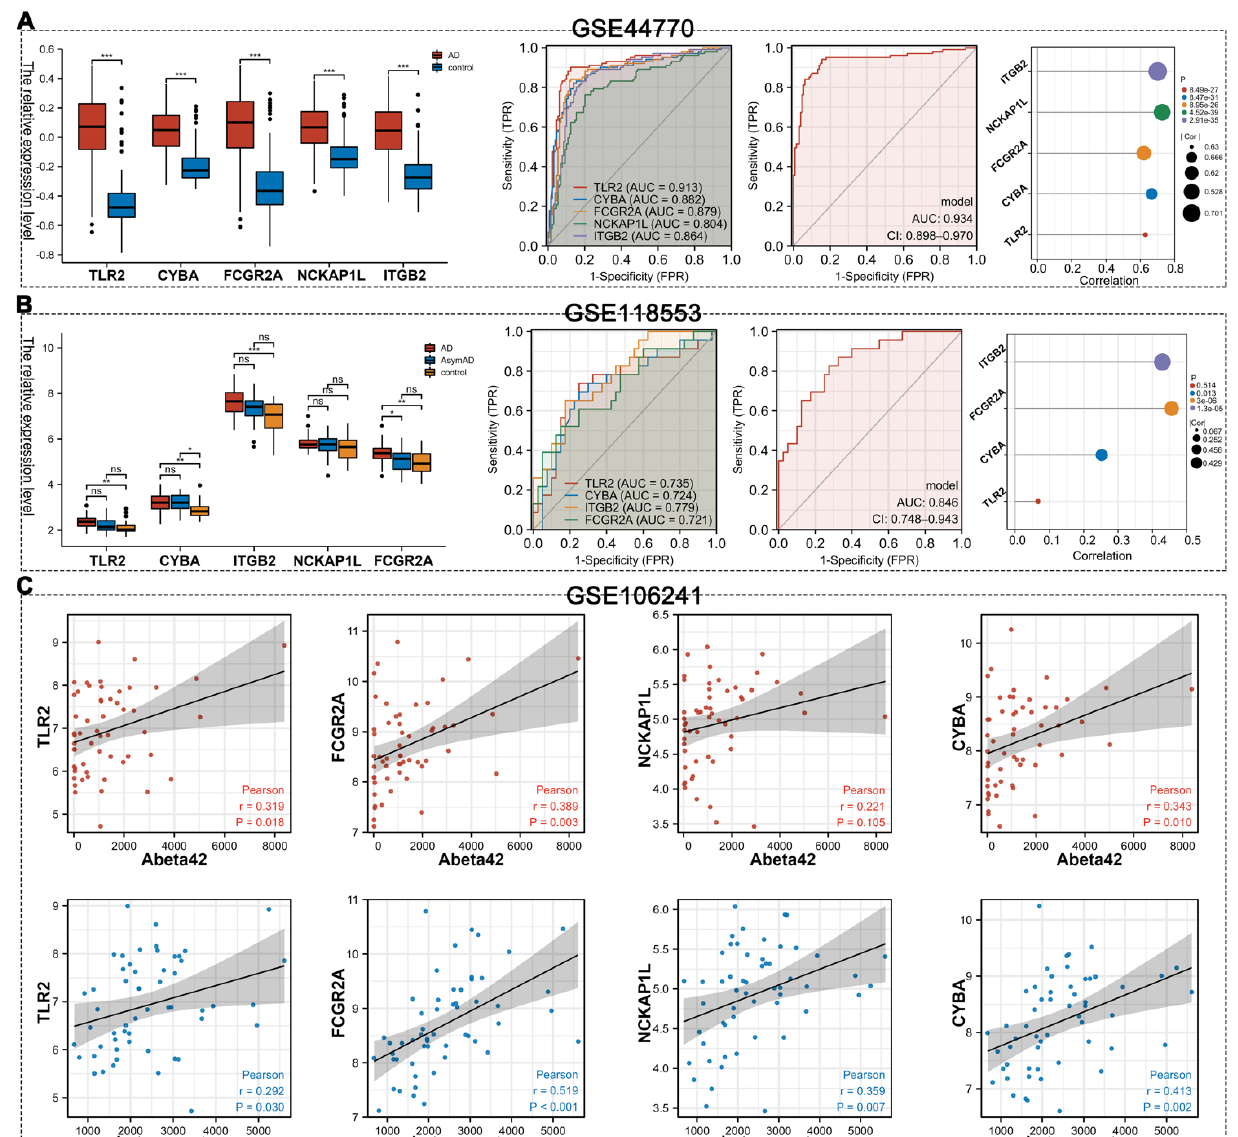
Figure 7. Validation of hub genes. ( A ) Validation of hub genes in the GSE44770 dataset. ( B ) Validation of hub genes in the GSE118553 dataset. ( C ) The relationship between hub genes and Aβ42 and β -secretase activity based on GSE106241. ns p > 0.05, * p < 0.05, ** p < 0.01, *** p < 0.001.